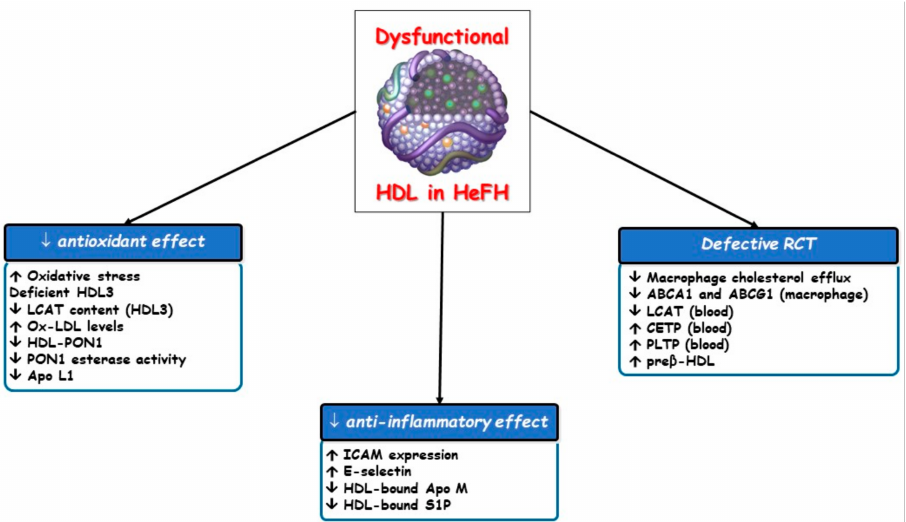
Figure 3. Impaired effects of dysfunctional HDL particles in HeFH. ABCA1, ATP-binding cas- sette transporter A1; ABCG1, ATP-binding cassette transporter G1; Apo, apolipoprotein; CETP, cholesteryl ester transfer protein; HDL, high-density lipoprotein; ICAM, intracellular adhesion molecule; LCAT, lecithin: cholesterol acyltransferase; Lp-PLA2, lipoprotein-associated phospholi- pase A2; PLTP, phospholipid transfer protein; PON1, paraoxonase type 1; RCT, reverse cholesterol transport; S1P, sphingosine-1-phosphate.